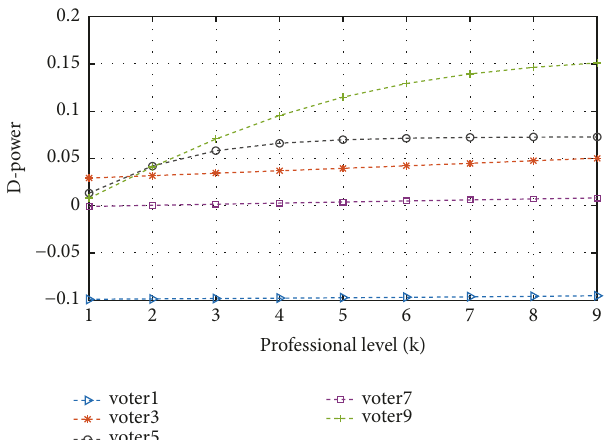
Figure 6: Influence of professionalism on power indices. Voters in the social network shown in Figure 4 play a repeated voting game—in whichthey havesocial learning behavioursthrough observing their neighbors—with voter 𝑖 ’s professional level 𝑘 𝑖 rising from 𝑘 𝑖 = 1 to 𝑘 𝑖 = 9 . To make it clearer, only changes in power indices ( 𝐷 - 𝑝𝑜𝑤𝑒𝑟(𝑖) = 𝑅 󸀠 (𝑖) − 𝐵 󸀠 (𝑖) ) of voter 1, voter 3, voter 5, voter 7, and voter 9 are shown. The changes in power indices improve with the professional level increasing, except for the isolated nodes.